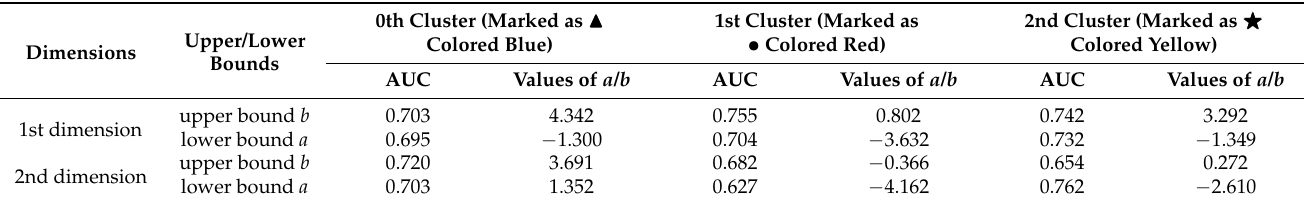
Table 1. The summary of the AUC values and bounds of different information granules.